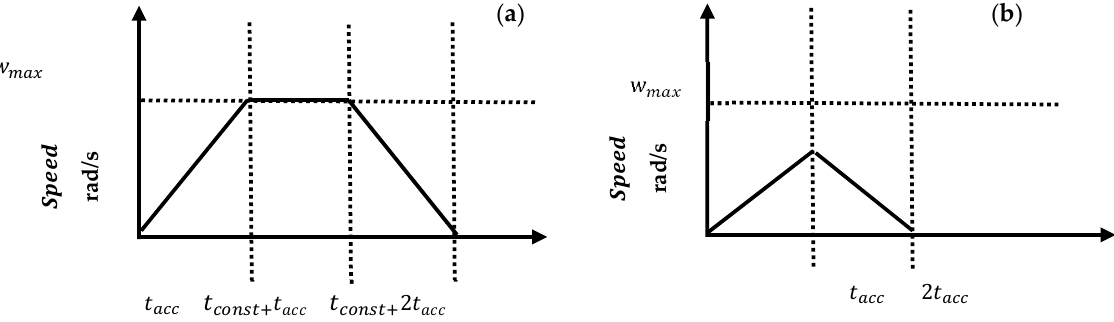
Figure 9. Speed profiles: ( a ) trapezoidal speed profile, ( b ) triangular speed